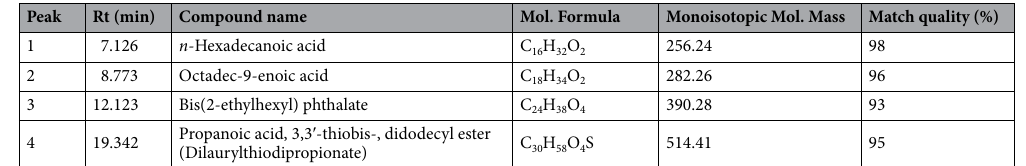
Table 6. GC–MS analysis of the dichloromethane (DCM) fraction of S. officinarum.